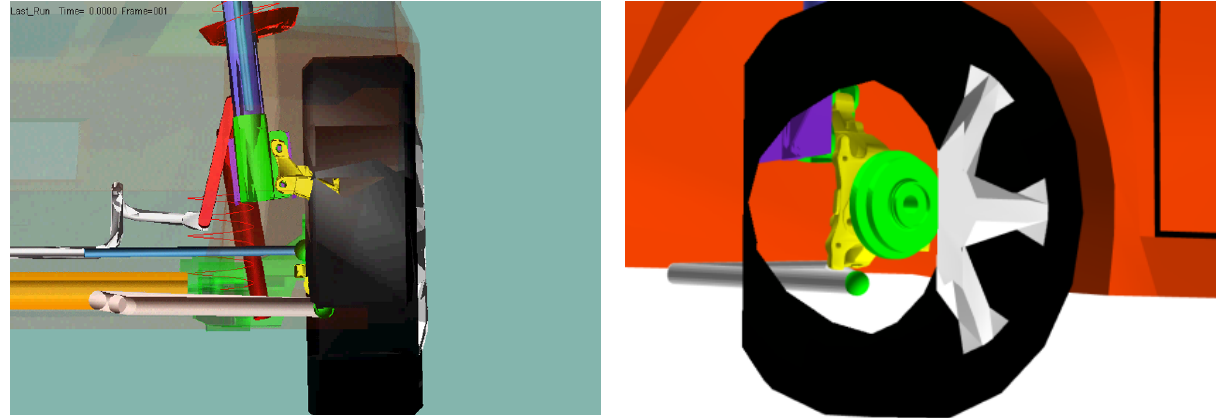
Figure 8: The car modelled in MSC.Adams. Details of the front left wheel suspension.